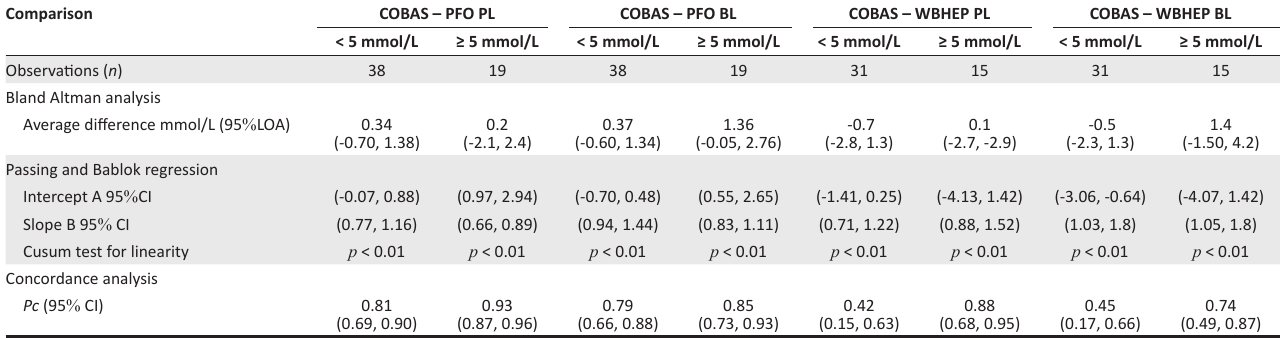
TABLE 2: Bland – Altman, Passing and Bablock and Concordance analysis of plasma lactate measured with a laboratory method compared with the Accutrend handheld meter with analysis split according to laboratory method lactate concentration < or ≥ 5 mmol/L. Lactate is measured on the Accutrend with different sample types using either the blood or plasma